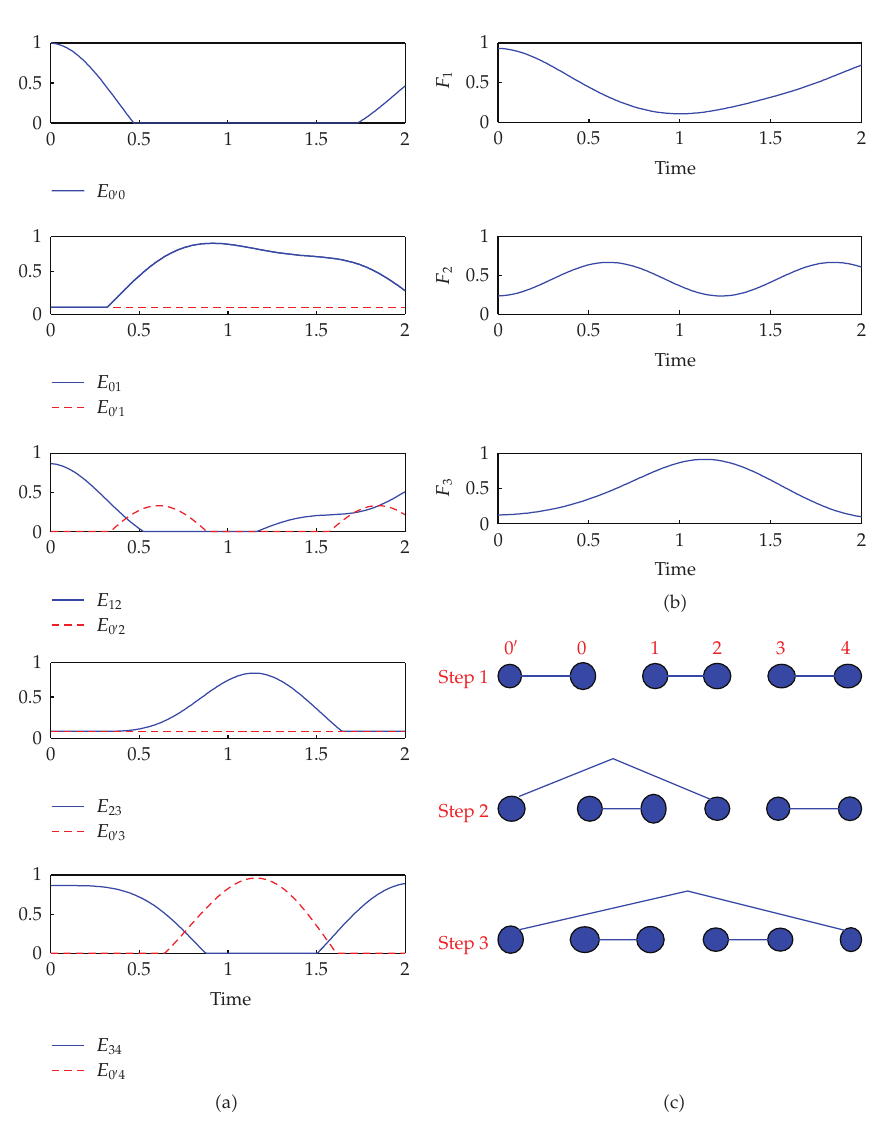
Figure 5: (cid:4) Color online (cid:5) The entanglement between site 0 (cid:2) and the other sites 0 , 1 , 2 ,...,N ch during the time evolution in an AFM chain of length N (cid:8)